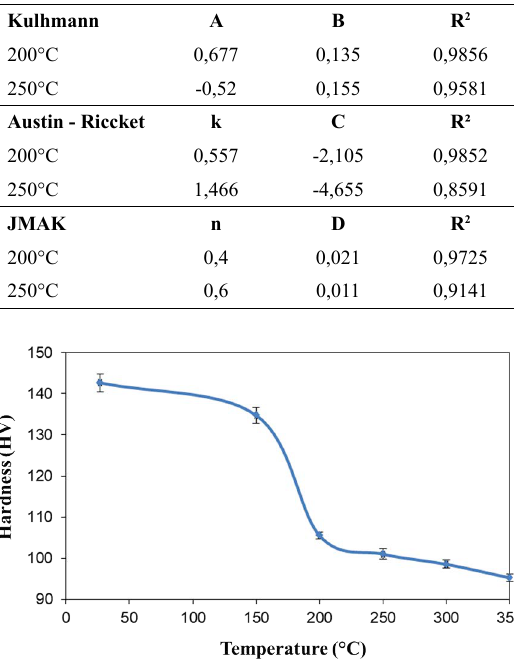
Figure 13. Softening behavior of cold-rolled (75%) samples annealed for 1 hour at different temperatures.